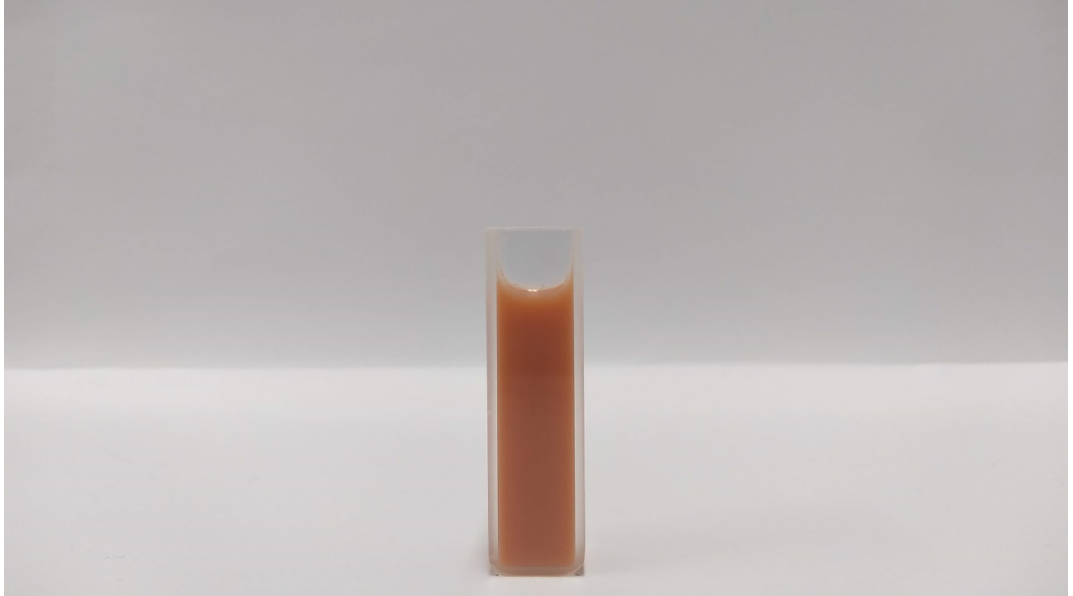
Fig 1. Cuvette image of the milk sample treated. Example of capture strategy using a common